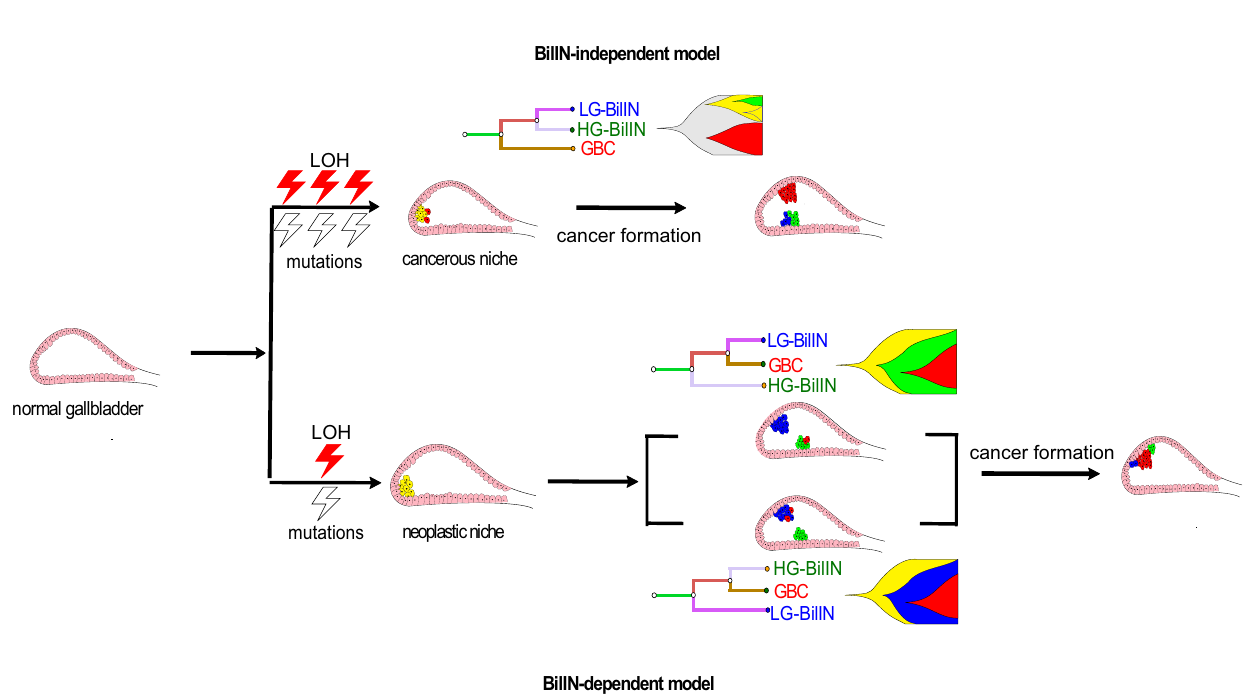
Fig. 5 Schematic representation of a proposed evolutionary model of GBC with coexisting LG-BilIN and HG-BilIN. In the BilIN-independent group, GBC tends to split earlier and evolve more independently from LG-BilIN and HG-BilIN in the cancerous niche that harbors extensive LOH and mutation events. In the BilIN-dependent group, the neoplastic niche needs a step-wise progression to achieve the malignant